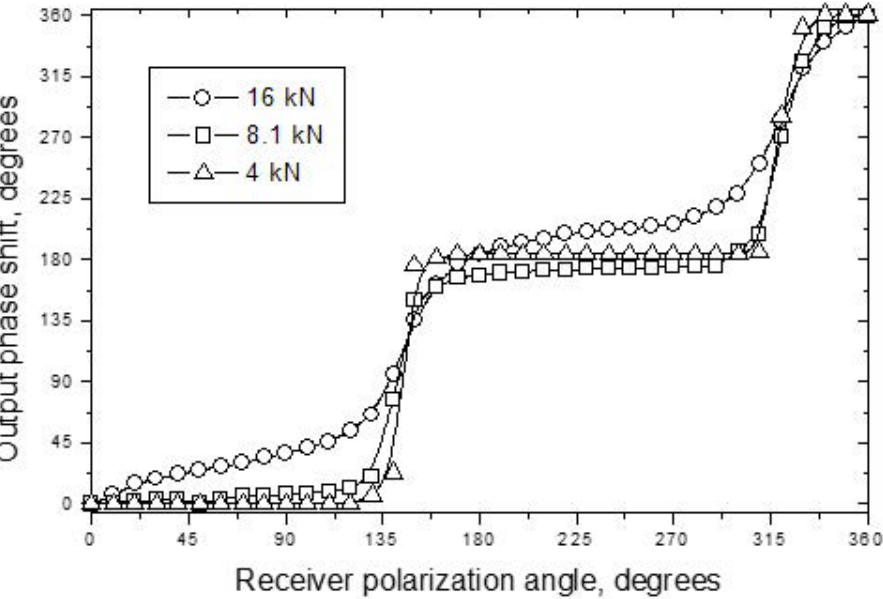
Figure 29. For different tensile loads applied to bi-axial (0–90 ◦ ) glass fabric